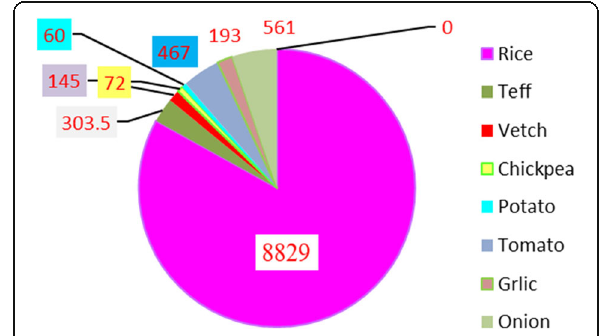
Fig. 5 Crop production in quintal in the year 2015 collected from sample household